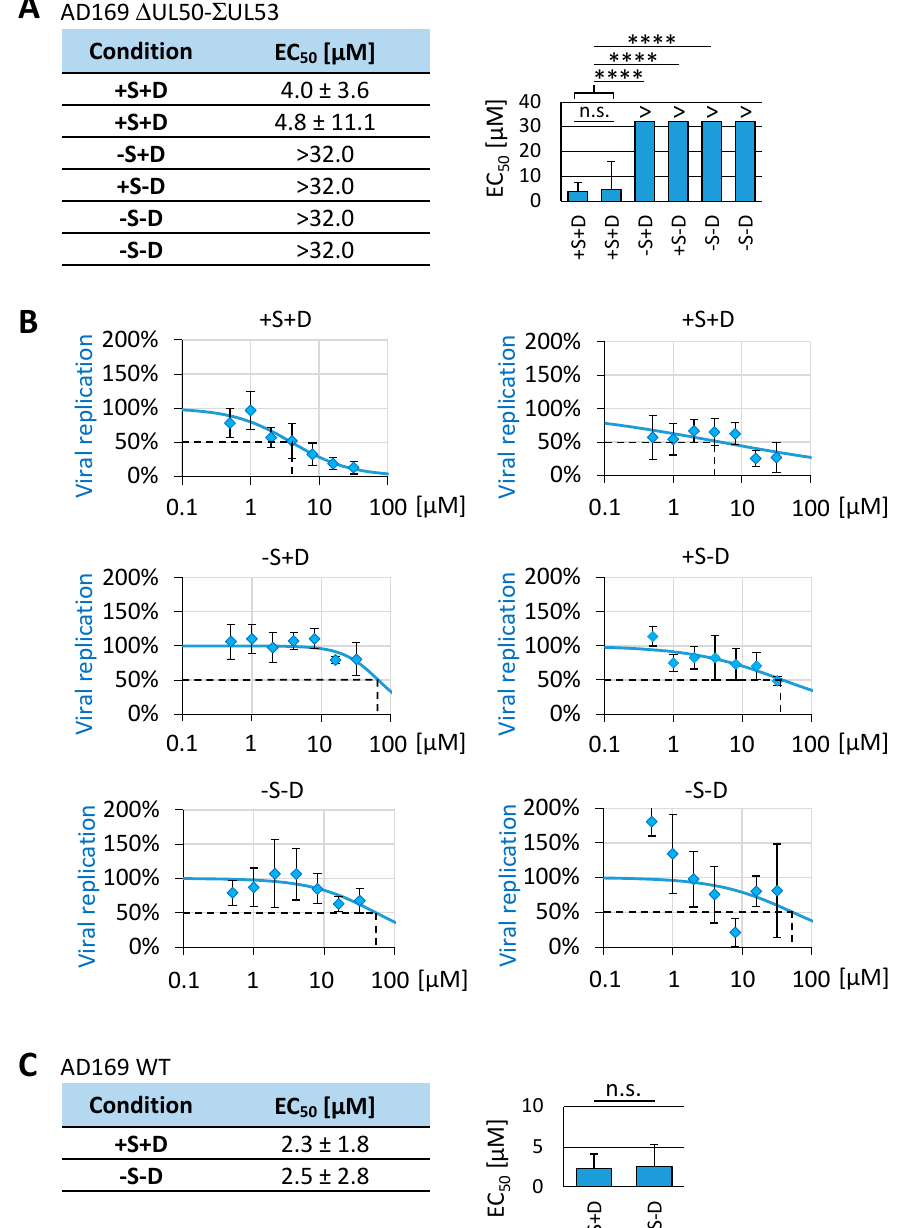
Figure 16. Loss of antiviral efficacy of ibrutinib in HCMV ∆ UL50- Σ UL53-infected cells under conditions that did not allow the expression of viral core NEC proteins as a drug target. HFF-UL50 cells were cultivated in 96-well plates and infected with ( A , B ) HCMV ∆ UL50- Σ UL53, with ( C ) parental HCMV AD169 (WT), using adjusted genome copy numbers, or remained uninfected (mock). Viral input was adjusted to 1 × 10 5 copies per well. Infected cells were treated with a serial concentration of ibrutinib ranging from 0.5 µM to 50.0 µM. Infected and treated cells were maintained under variable conditions, including the indicated combinations of Shield-1 (± Shield-1, 1 µM) and Dox (± Dox, 500 ng/mL) addition. Dox was refreshed every second day. At 14 d p.i., supernatants were harvested, and viral genome equivalents were determined using HCMV IE1-specific qPCR. Each condition was examined in biological quadruplicates; mean values ± SDs are shown. In addition, the conditions, +S + D and − S − D, were given by two independent experimental replicates (whereby the second − S − D setting (panel B, lower right) had the highest SD and was excluded from statistics shown in panel ( A )). Statistical analysis was performed using ordinary one-way ANOVA and post hoc Tukey testing; **** p ≤ 0.0001; n.s., not